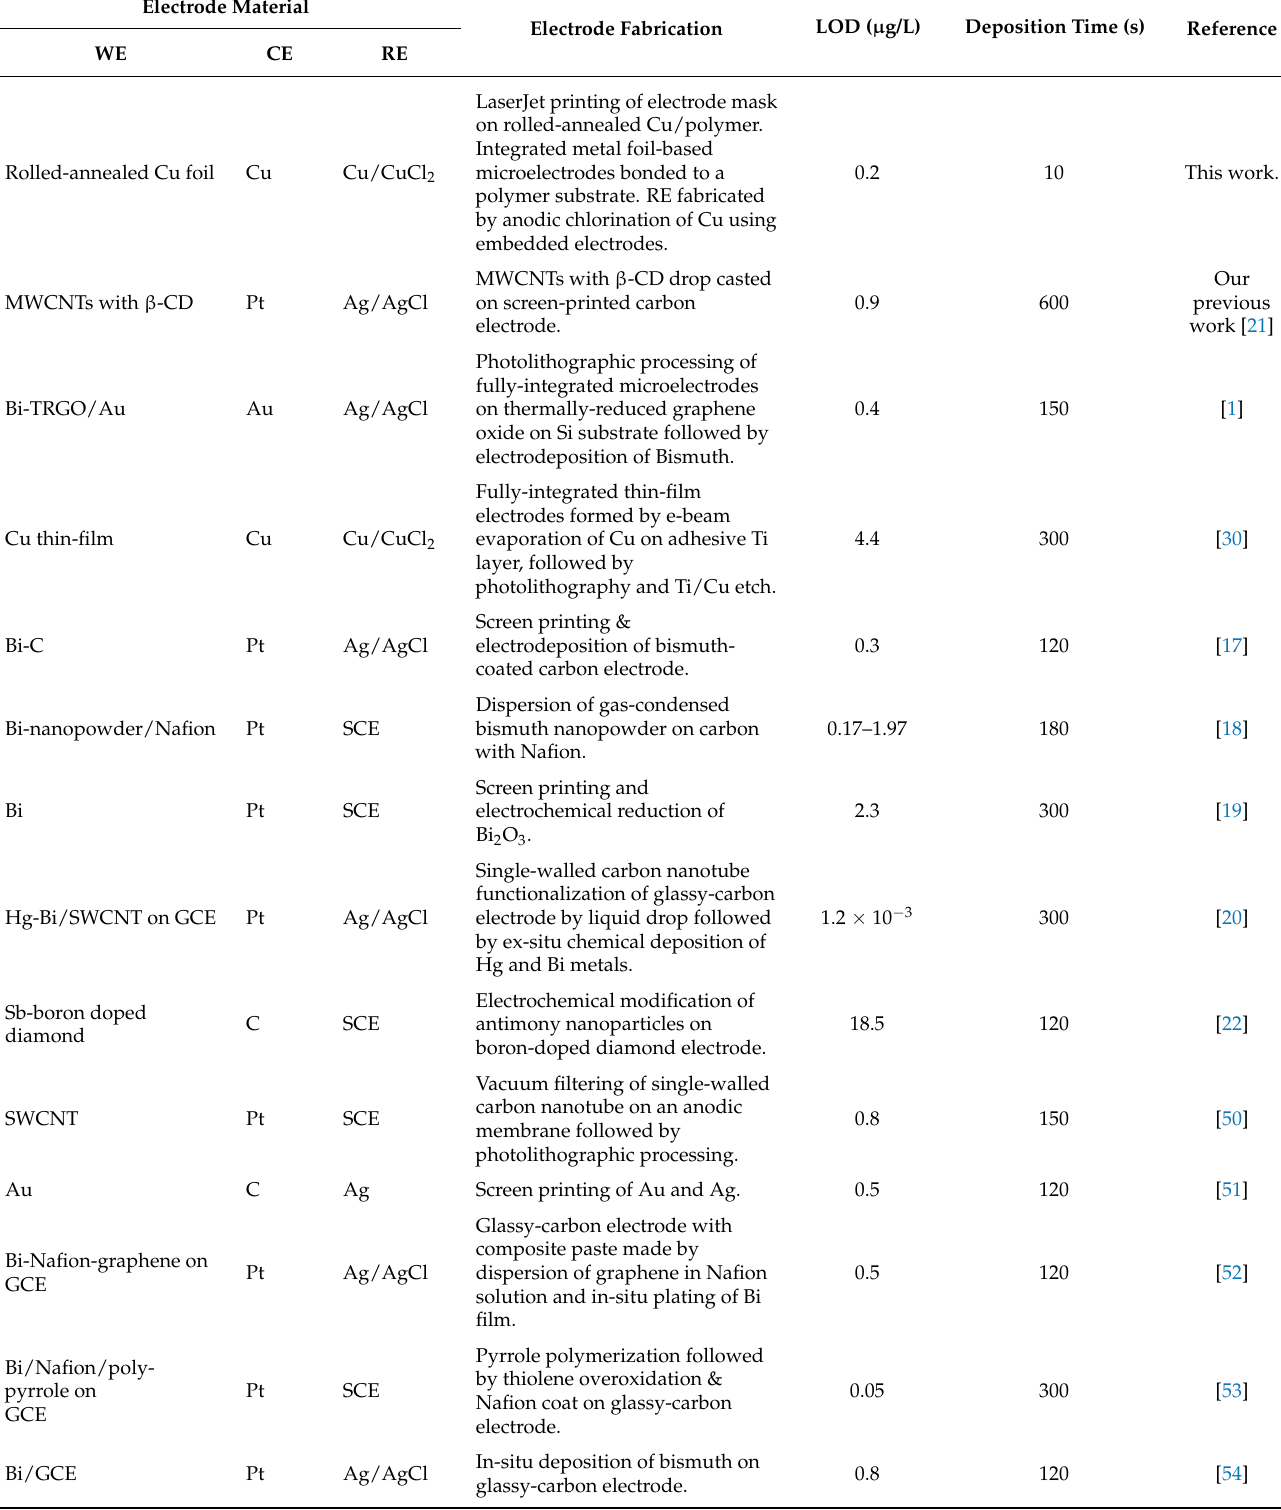
Table 3. Comparison of this work with similar electrochemical Pb